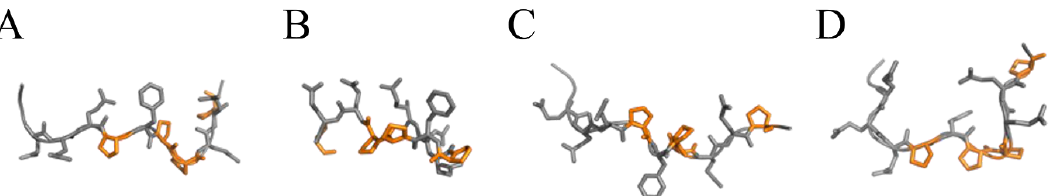
Figure 1. P31–43 (L 31 GQQQPFPPQQPY 43 ) modelled in ( A ) ‘all trans ’, ( B ) cis Gln35-Pro36, ( C ) cis Phe37- Pro38, and ( D ) cis Pro38-Pro39 configurations. Proline residues are colored in gold.